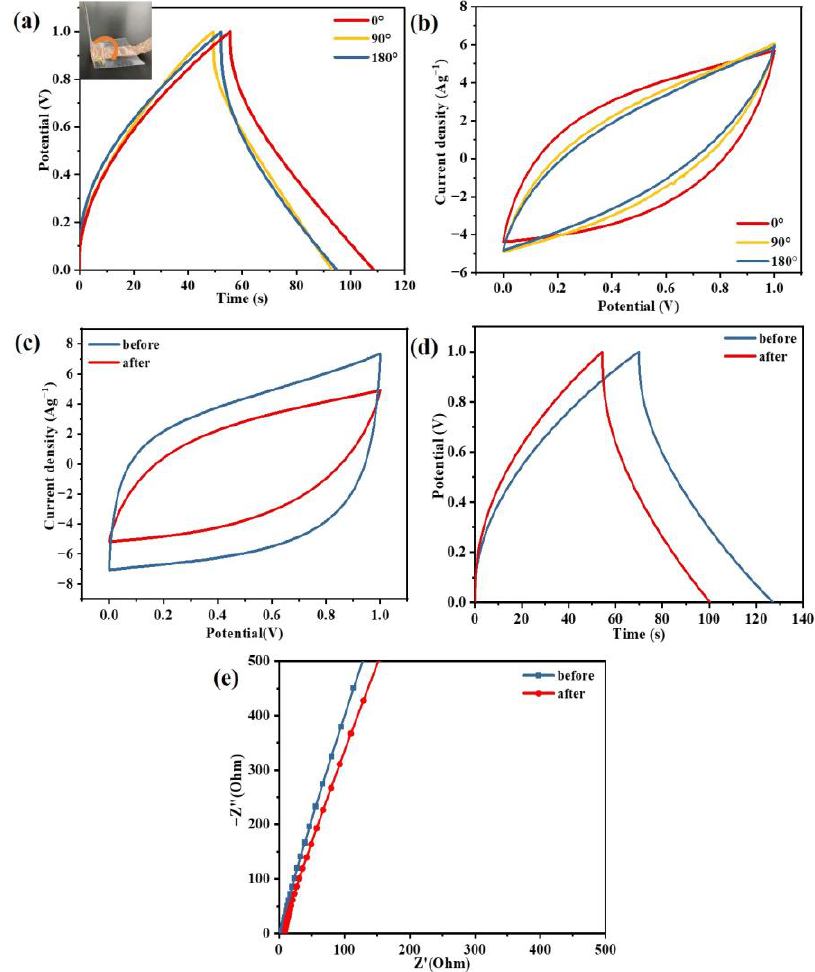
Figure 8. ( a ) CV curves at a scan rate of 100 mV s −1 for the EDLCs, based on MCIGPE−65 with dif- ferent bending angles (the inset show the digital photo of the EDLC bend to 90°), ( b ) GCD profiles at a current density of 1 A g −1 , ( c ) CV curves at 100 mV s −1 , ( d ) GCD profile at 1 A g −1 , and ( e ) im- pedance spectra of MCIGPE−65 at 35 °C before and after the healing cycle. ( e ) impedance spectra of MCIGPE − 65 at 35 ◦ C before and after the healing